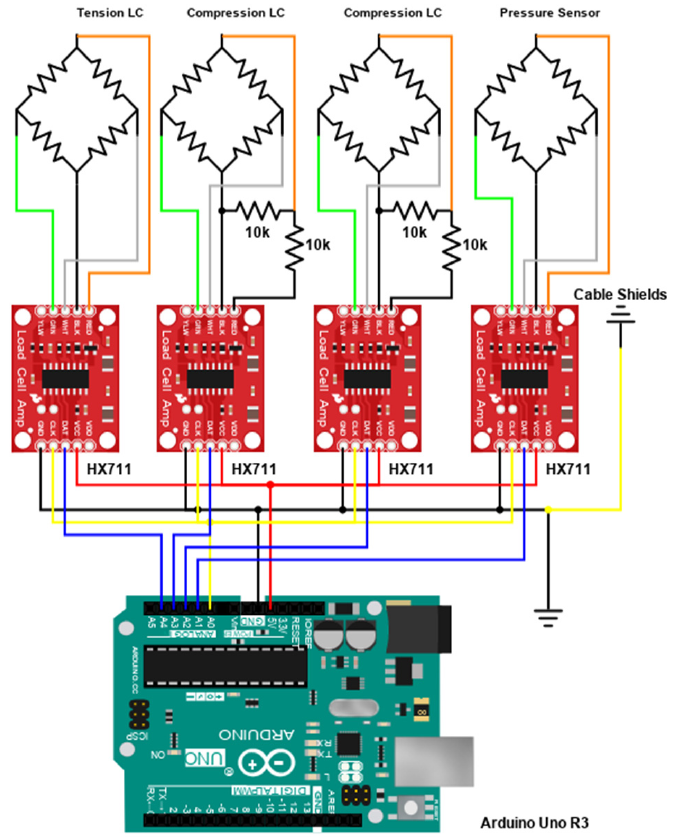
Figure A2. Circuit diagram used for the test setup.